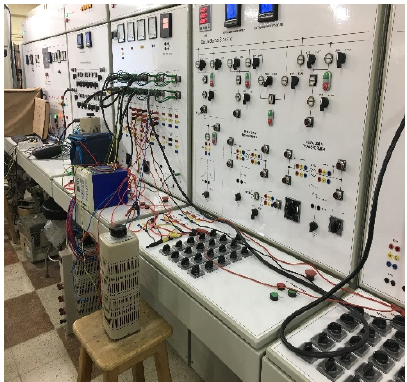
Figure 6. Power simulator set. Table 4. Laboratory and simulation result of single-phase to ground fault.